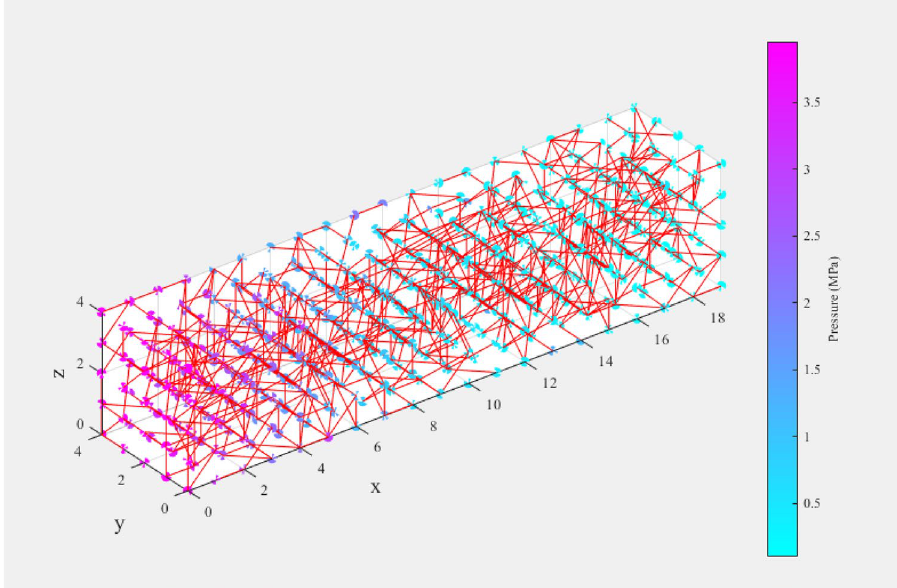
Figure 9. Illustration of a swelling pore network (Constructed using Matlab and C++).